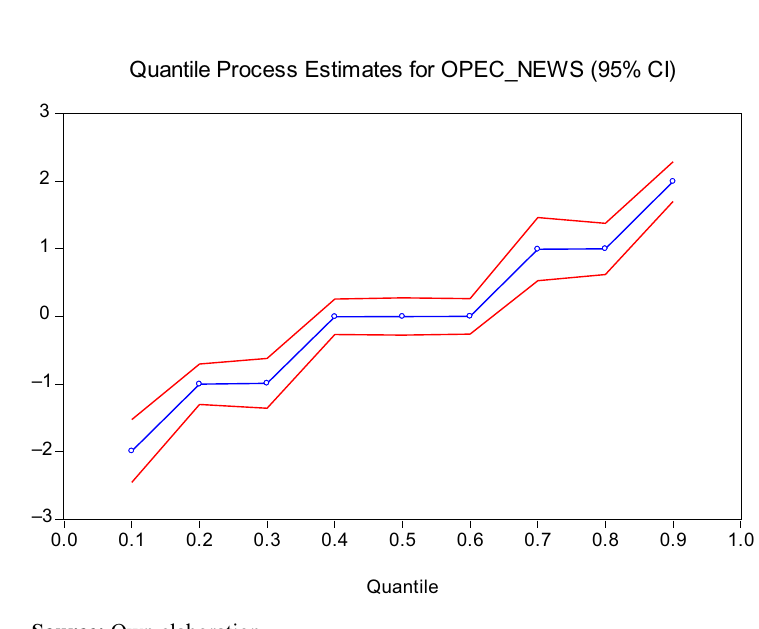
Figure 16. The quantile process estimates for OPEC news on the heating oil futures overthe period from April 01, 2013 to June 30,